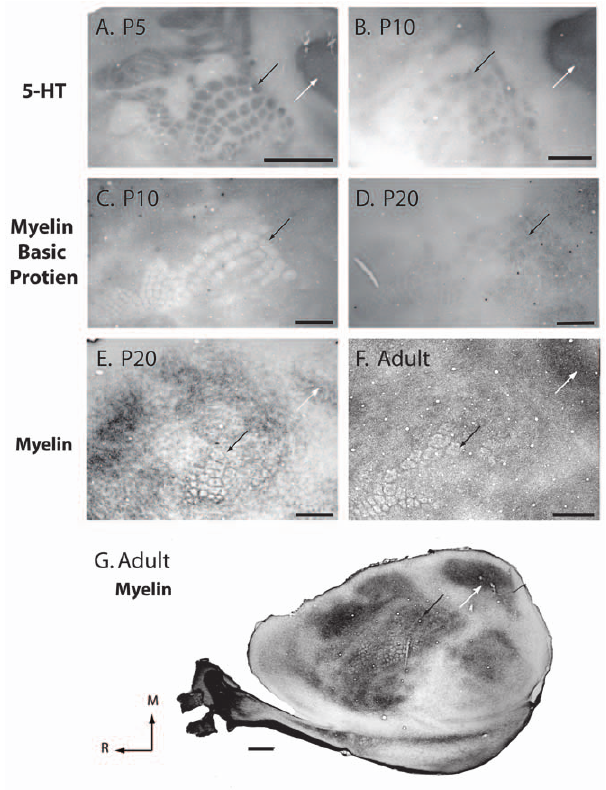
Figure 6. Differential effectiveness of cortical staining tech- niques. Photomicrographs of primary somatosensory cortex in 5-HT- (A and B), MBP- (C and D), and myelin-stained sections (E, F, and G) in P5 (A), P10 (B and C), P20 (D and E), and adult (F and G) subjects. Visible barrels are indicated with black arrows, and V1 is indicated with white arrows. Different stains work best at different ages. Images were imported into Adobe Photoshop and levels were adjusted to increase contrast. In all photomicrographs, medial is to the top and rostral is to the left. See Table 1 for abbreviations. Scale bar=1 mm.